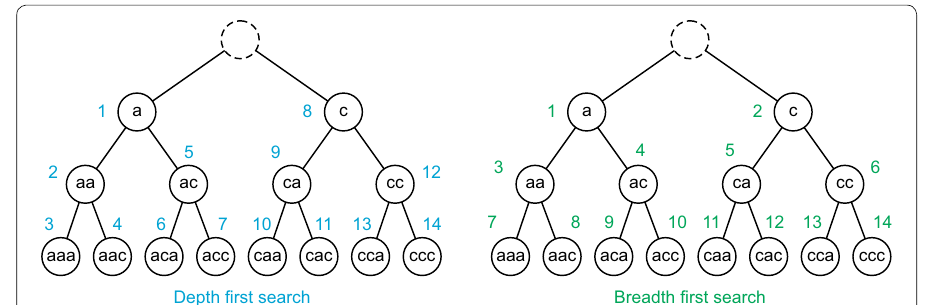
Fig. 1 Depth first search and breadth first